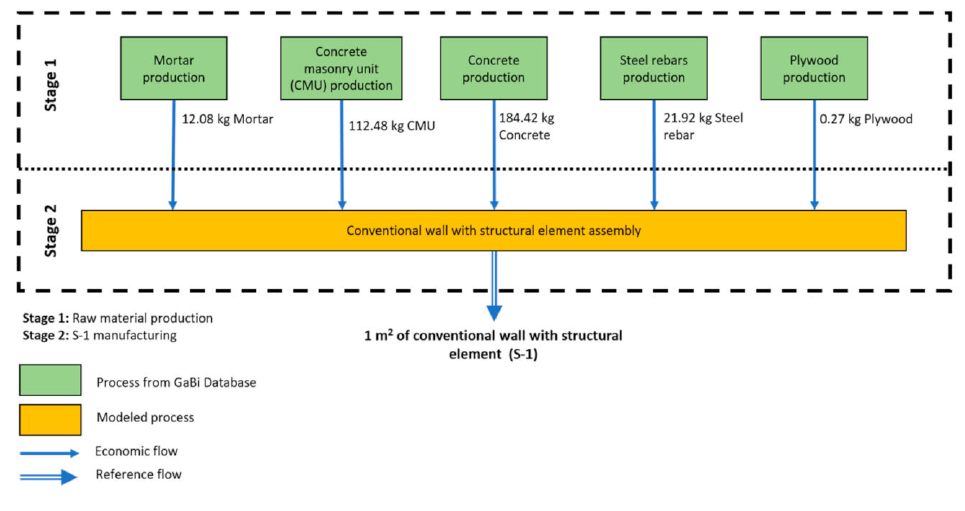
Figure 3. Flowchart of S-1.